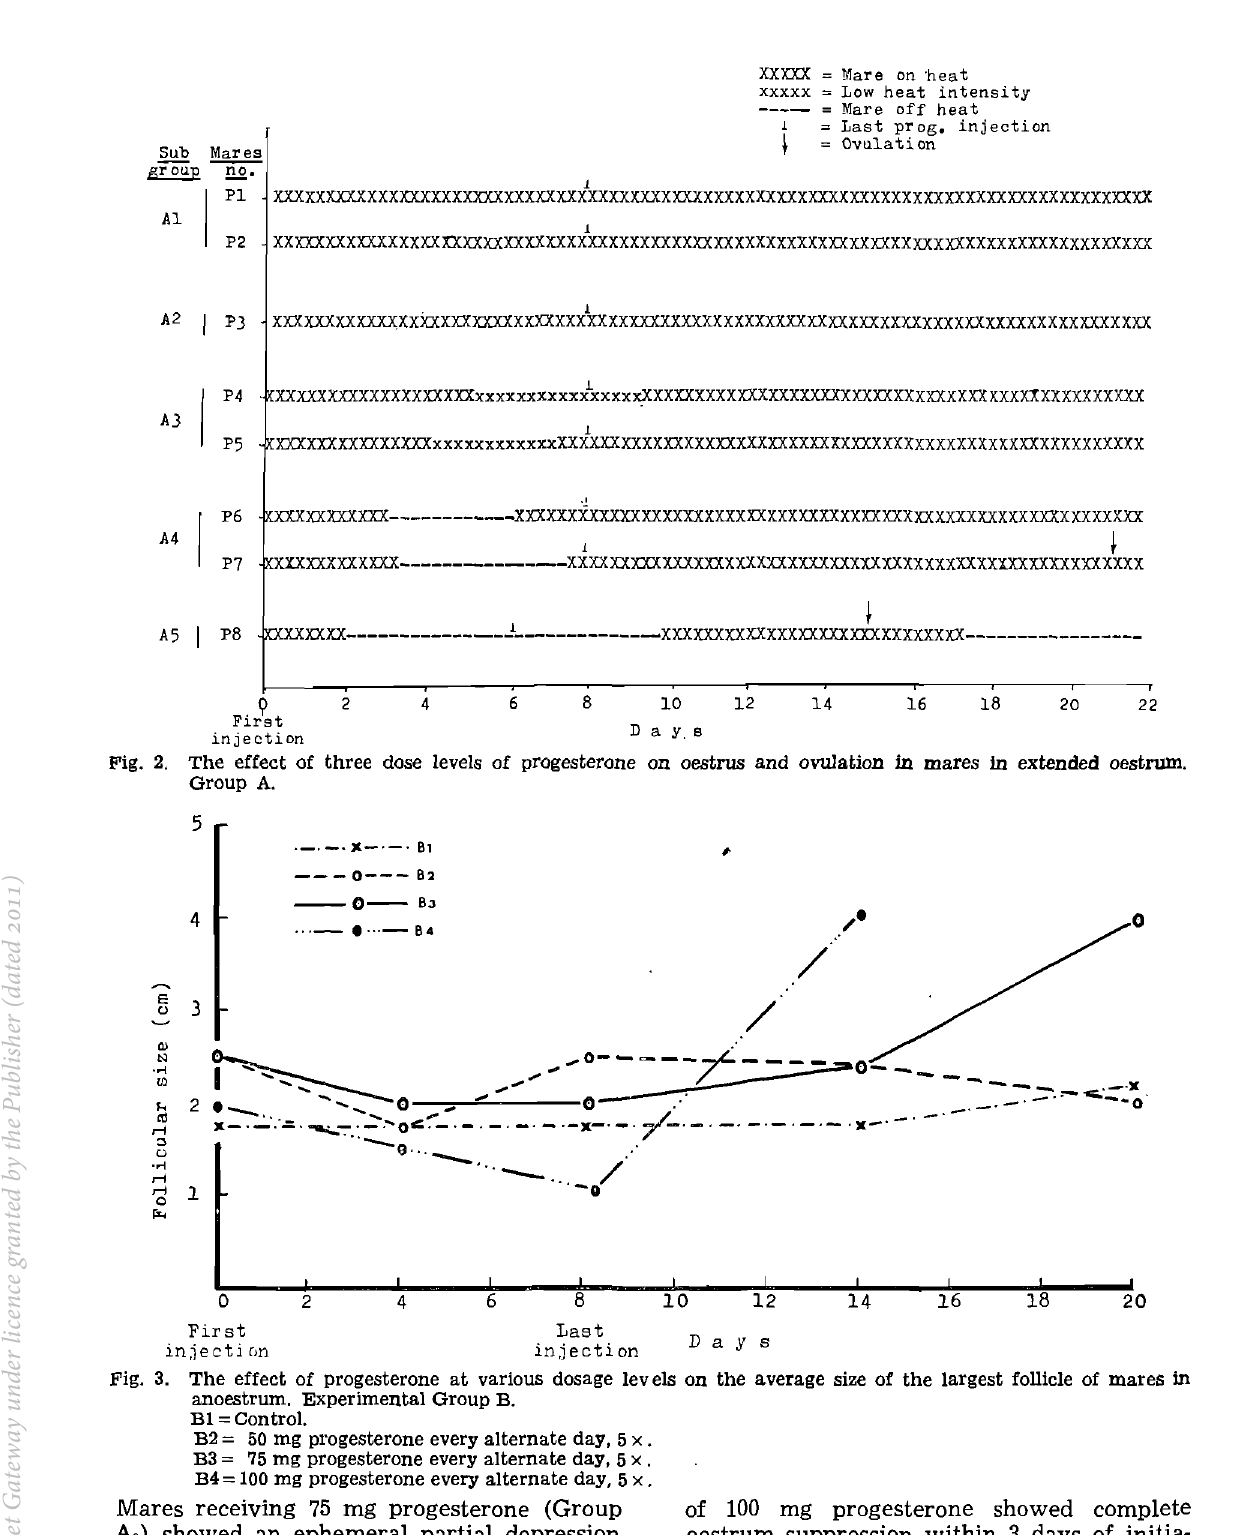
Fig. 3. The effect of progesterone at various dosage levels on the average size of the largest follicle of mares in anoestrum. Experimental Group B. B1 = Control. B2 = 50 mg progesterone every alternate day, 5 x . B3 = 75 mg progesterone every alternate day, 5 x . B4 = 100 mg progesterone every alternate day, 5 x